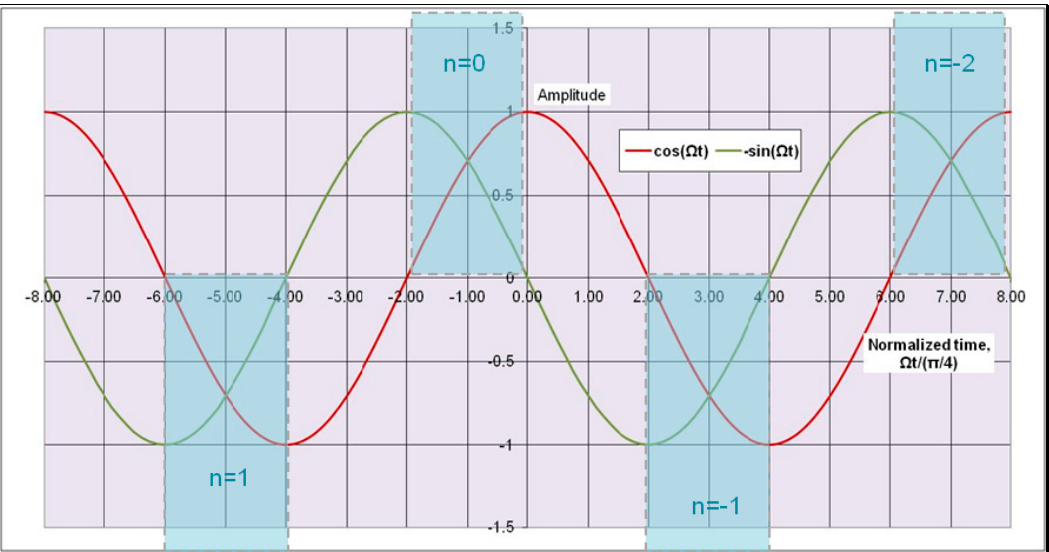
Figure 8. Antenna modulating waveforms with output gating intervals shaded.